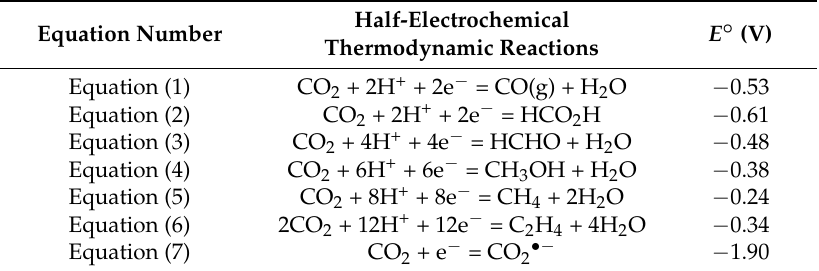
Table 1. Selected standard potentials of CO 2 reduction in aqueous solutions 1